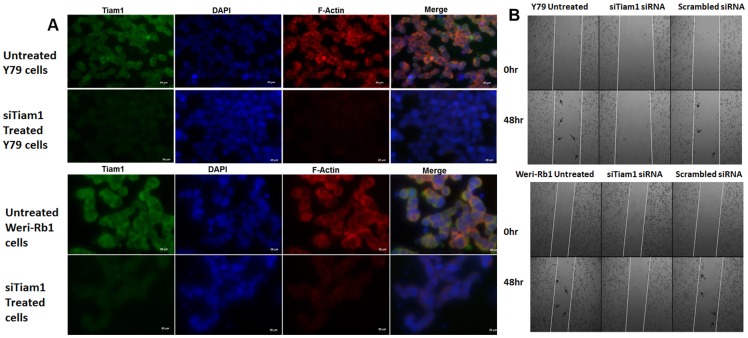
F-actin staining and invasion of Tiam1 deficient RB cell lines.
A. Tiam1 silenced Y79 cells and Weri-Rb1 cells were fixed, immunofluorescently labeled for Tiam1, nucleus stained with DAPI, stained with phalloidin and images were taken at 40X in ten fields. Bar represents 20 μm. B. Phase contrast microscope images of wound healing assay showing the cell migration pattern in Tiam1 deficient retinoblastoma cell lines at 0 hr and 48 hrs post silencing. Tiam1 knockdown cells were unable to migrate whereas the untransfected and control cells showed increased migration, migrated cells were indicated with arrows. The images were acquired using AxioObserver microscope at 5× objective with 1× optovar.